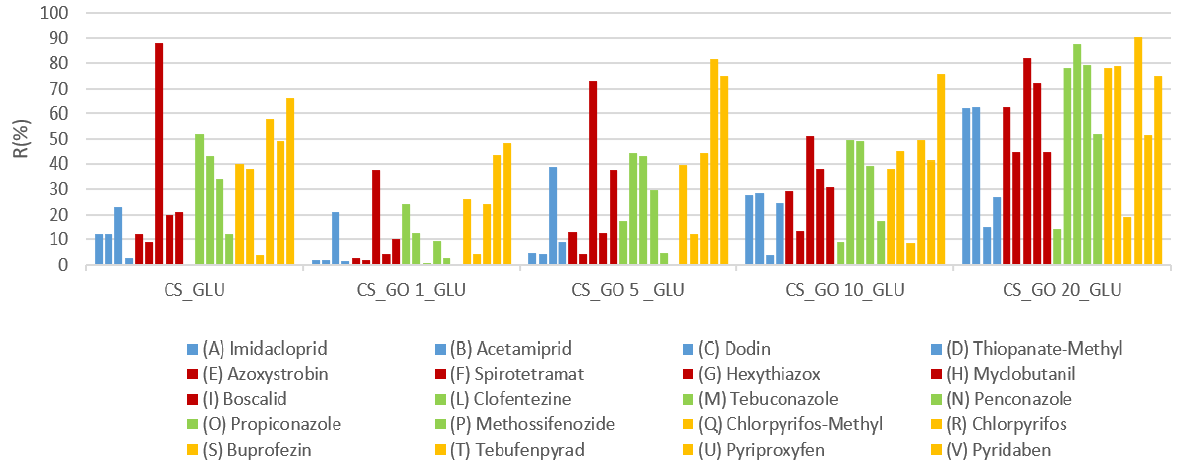
Figure 6. Recovery capacity of the CS_GLU and CS_GOX_GLU composite membranes. Pesticides are reported in ascending order of log K ow .